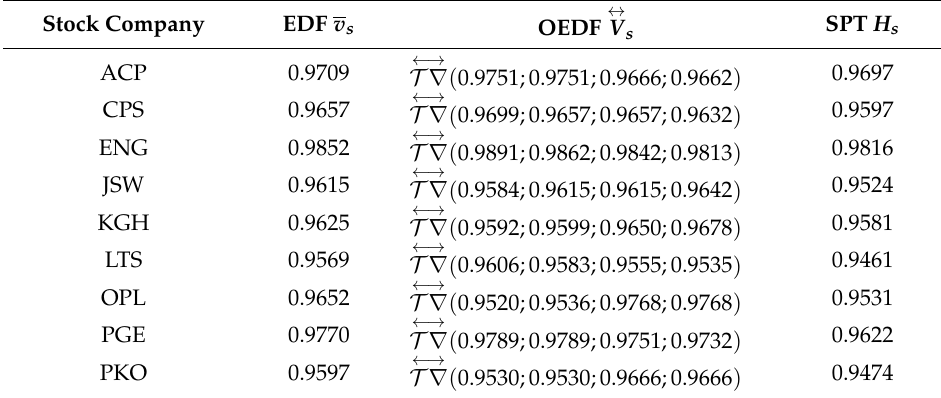
Table 2. Expected discount factors of portfolio π